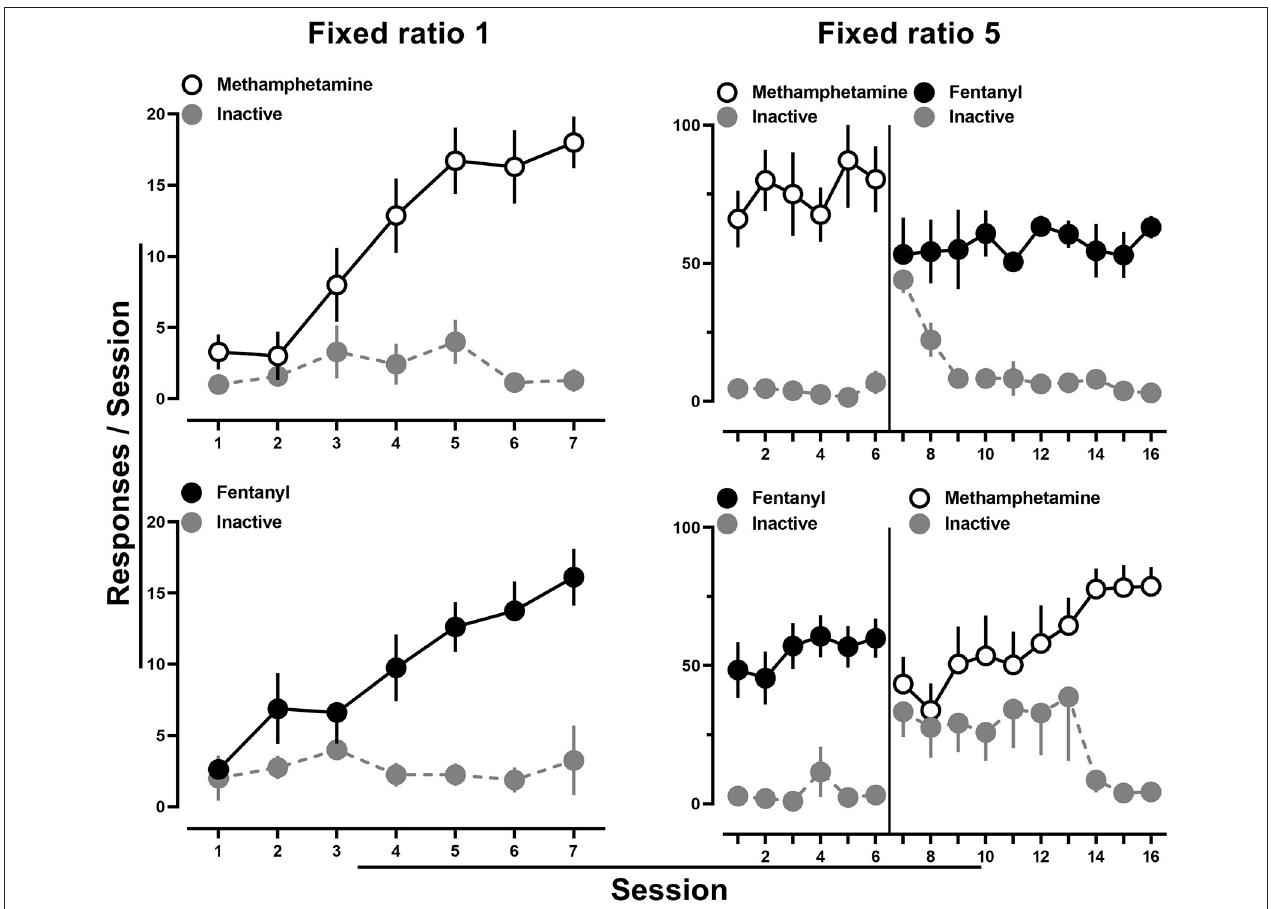
FIGURE 1 | Number of active and inactive lever responses throughout the 7-day acquisition period for methamphetamine (0.1 mg/kg/infusion) (upper left) or fentanyl (0.0032 mg/kg/infusion) (lower left). Subsequent responding under a fixed ratio five schedule of reinforcement for methamphetamine and when fentanyl was substituted on the previously inactive lever (upper right). Similarly, responding under a fixed ratio five schedule of reinforcement for fentanyl followed by methamphetamine substitution on the previously inactive lever (lower right). The solid line represents when the alternate drug and drug-paired stimuli were made available on the alternate lever. Data represent the mean ± S.E.M., and each point represents 7–8